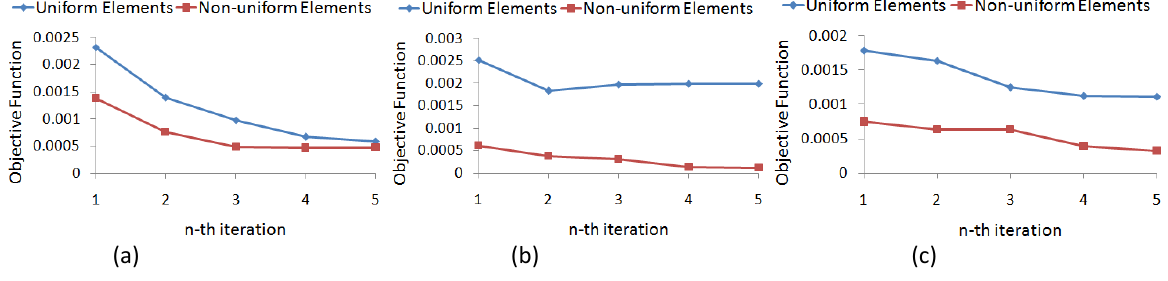
Figure 14: Objective function from iteration process of neighboring collection methods